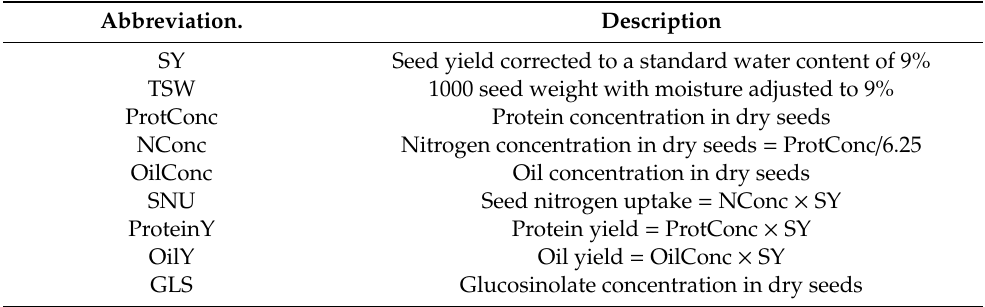
Table 1. Definition of yield and harvest quality